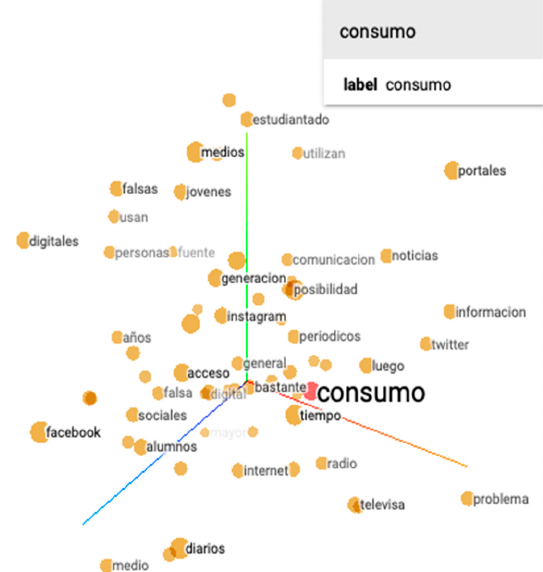
Figure 3. Visualization of the “consumption” vector.